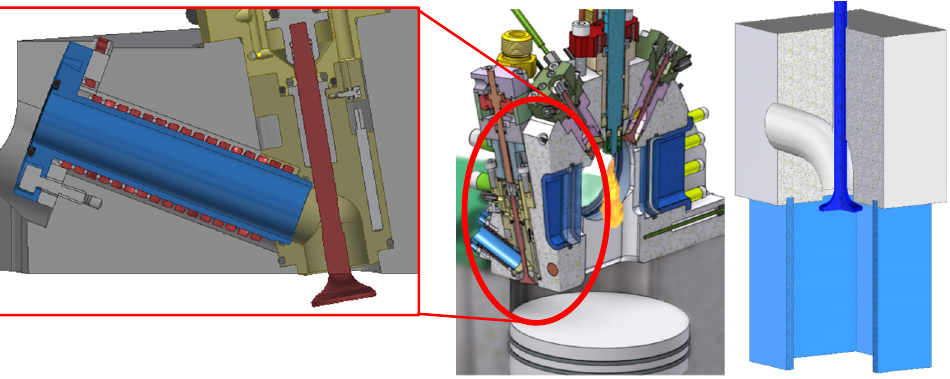
Figure 1. Geometry of the Flex-OeCoS inlet valve and the combustion chamber ( left ) and simplified geometry ( right ). geometry ( right ).